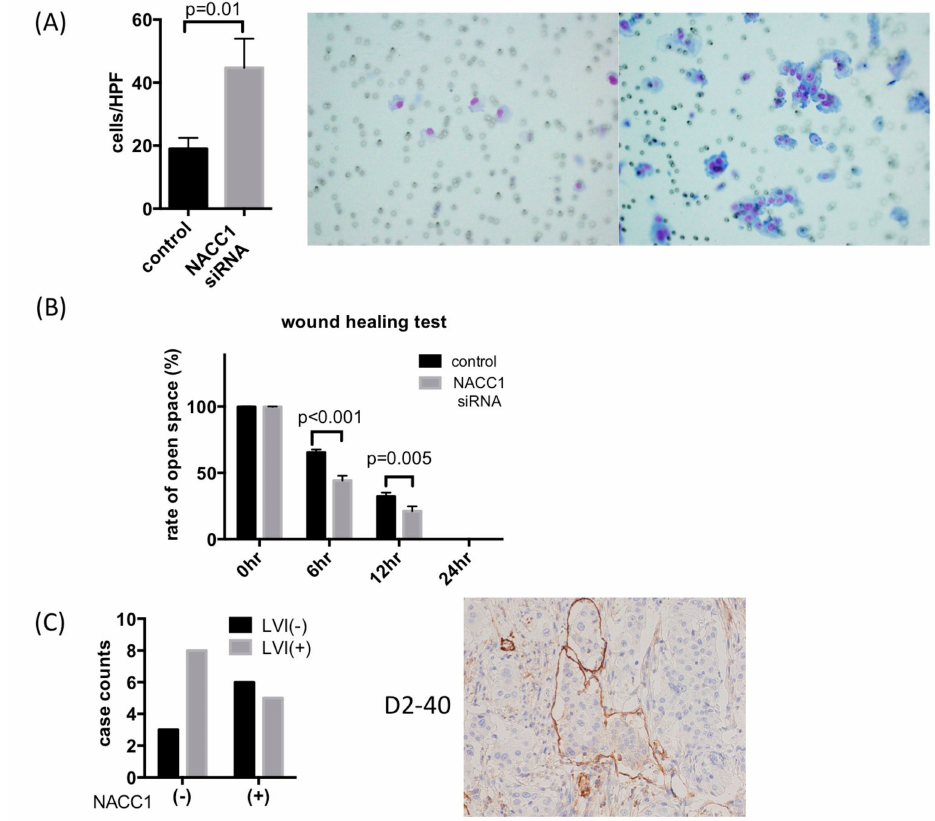
Figure 6. Cell invasion and migration assay in T24 cells. ( A ) Matrigel invasion assay showing promotion of invasion capability of T24 cells transfected with NACC1 siRNA; ( B ) Representative images and graphical display of rate of open space in wound closure (%) in T24 cells; ( C ) Immunohistochemistry for D2-40. In total, 22 cases of invasive UC were assessed. Scale bar: ×